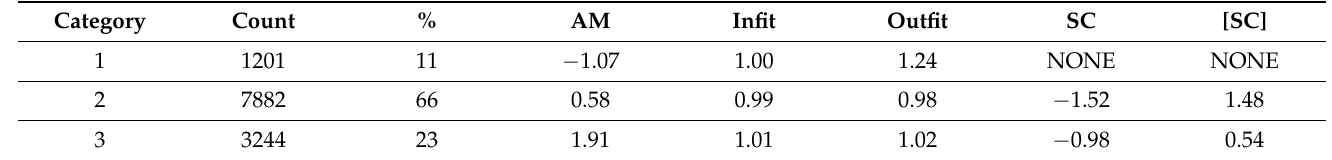
Table 8. Verification of 3-point Likert Scale’s